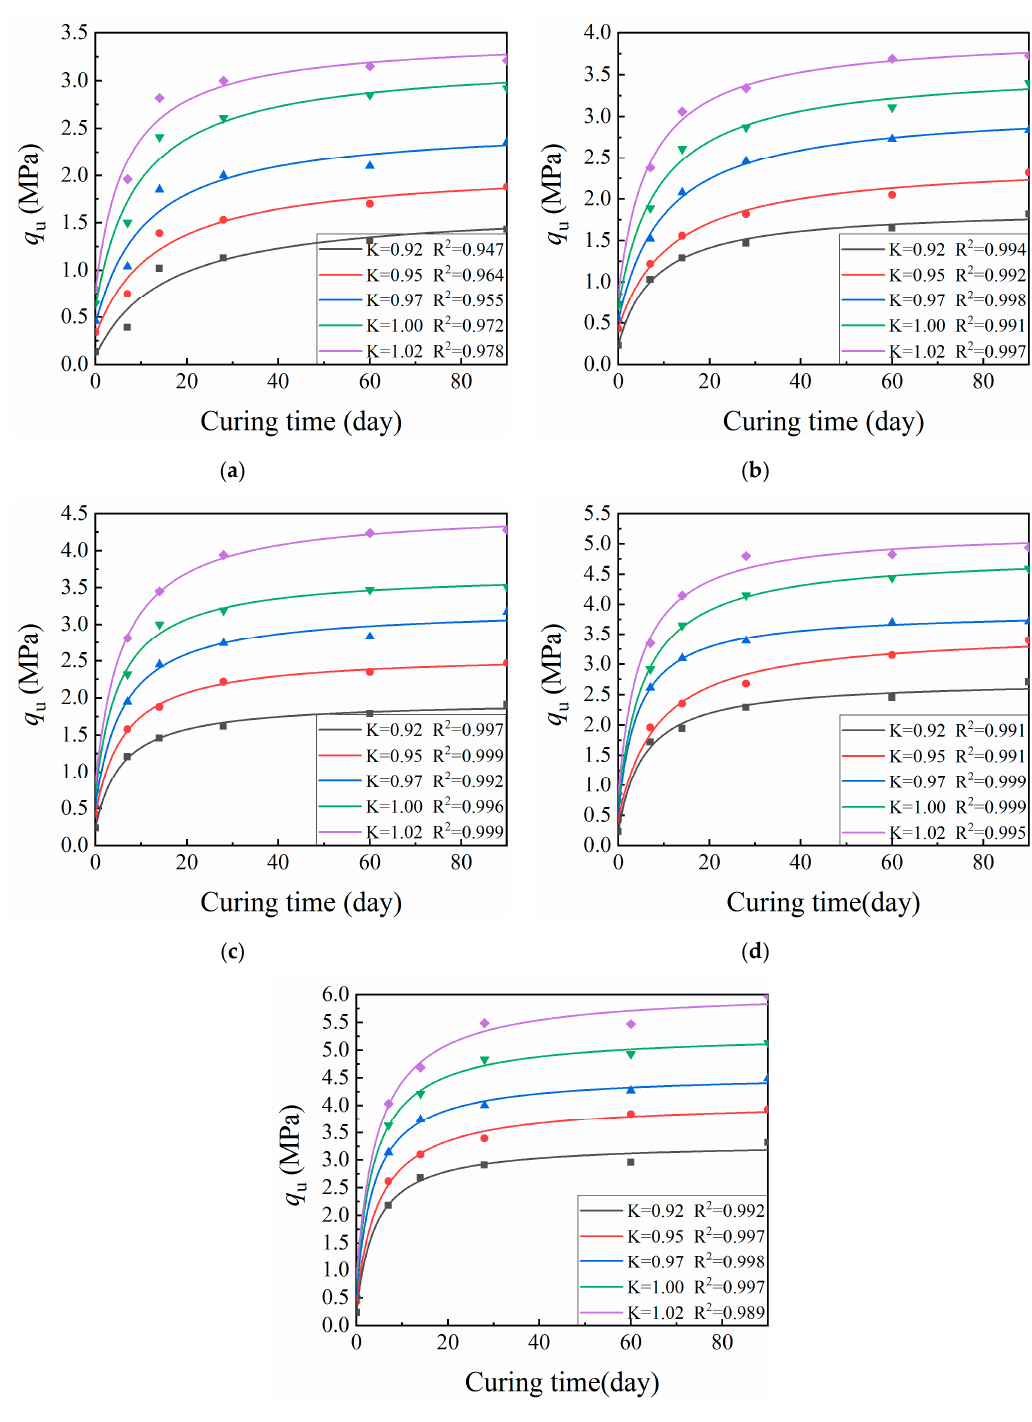
Figure 4. Relationship between age and compressive strength for cement-improved loess: ( a ) cement dosage 2%; ( b ) cement dosage 3%; ( c ) cement dosage 4%; ( d ) cement dosage 6%; and ( e ) cement dosage 8%. K is the compaction coefficient of the specimen.